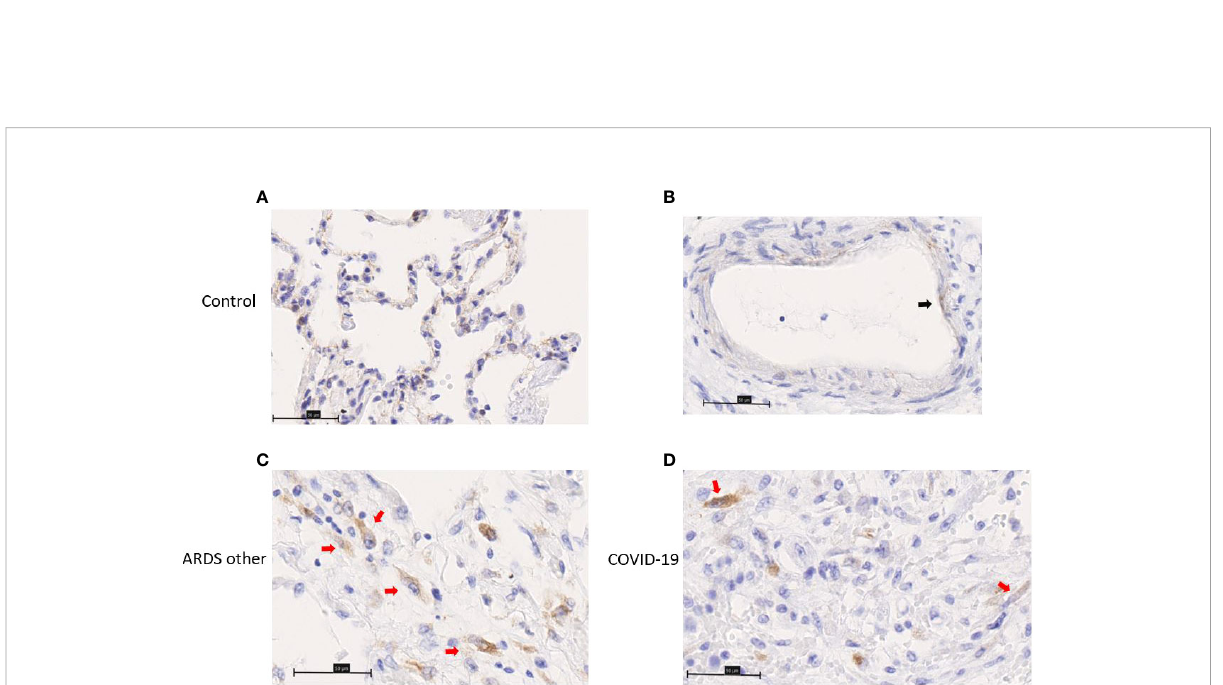
FIGURE 5 Immunohistochemistry staining of chemerin on lung slides from autopsied COVID-19 patient, patient with ARDS from another origin (ARDS other) and control. (A) Representative image of alveolar lining staining. (B) Representative image of endothelial cell (black arrow) staining. (C, D) Representative image of chemerin staining of spindle cell (red arrows) in organizing phase of diffuse alveolar damage. Field magni fi cation 400x. Scale bar: 50µm.